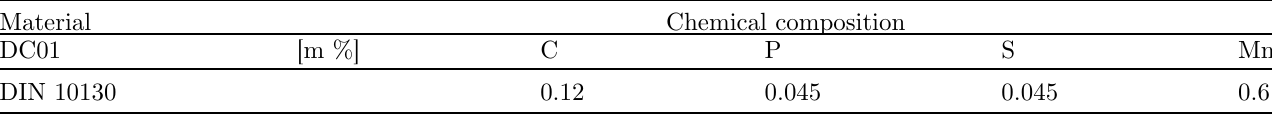
Table 2. Properties of selected adhesive according to technical data sheet.